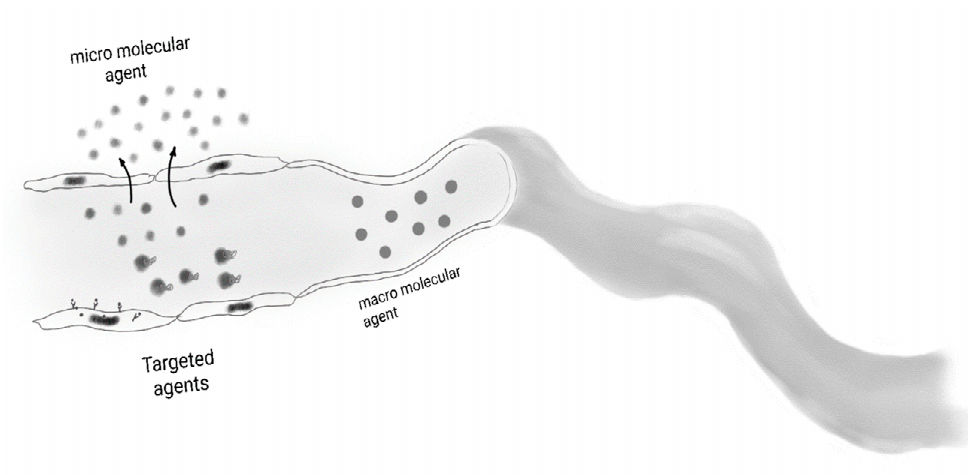
Figure 5. Graphic illustrates various contrast medias used in contrast ‐ enhanced MRI, such as ultrasmall superparamagnetic iron oxide (USPIO). The small molecular agents leak through the vessel walls. Macromolecules remain in the vascular compartment. Similarly, ligand ‐ bound contrast material remains in the vascular compartment. Targeted agents are bound to surface target molecules.